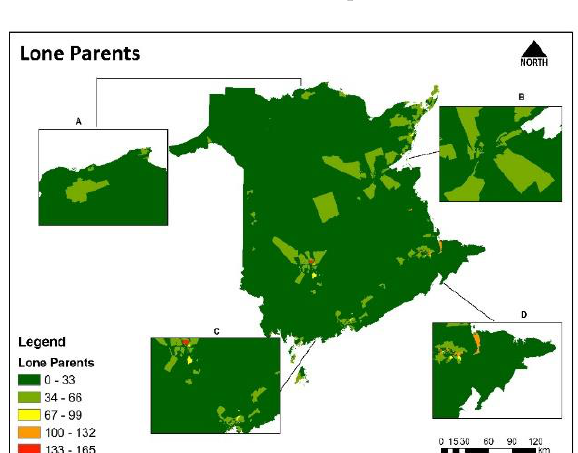
Figure A7. Floodplain.